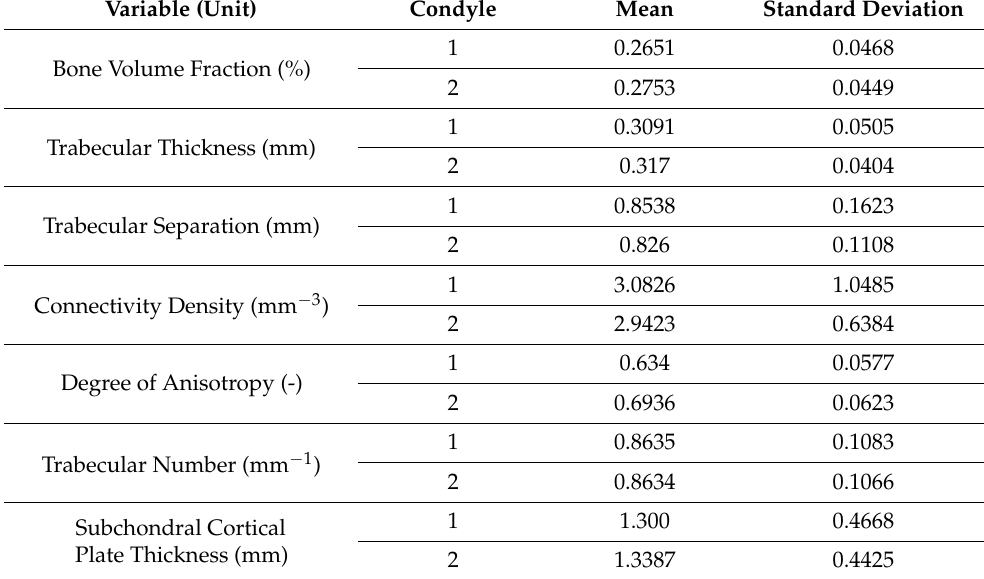
Table 4. Mean statistics for all morphometric variables by condyle region. Note: lateral condyle = 1; medial condyle =